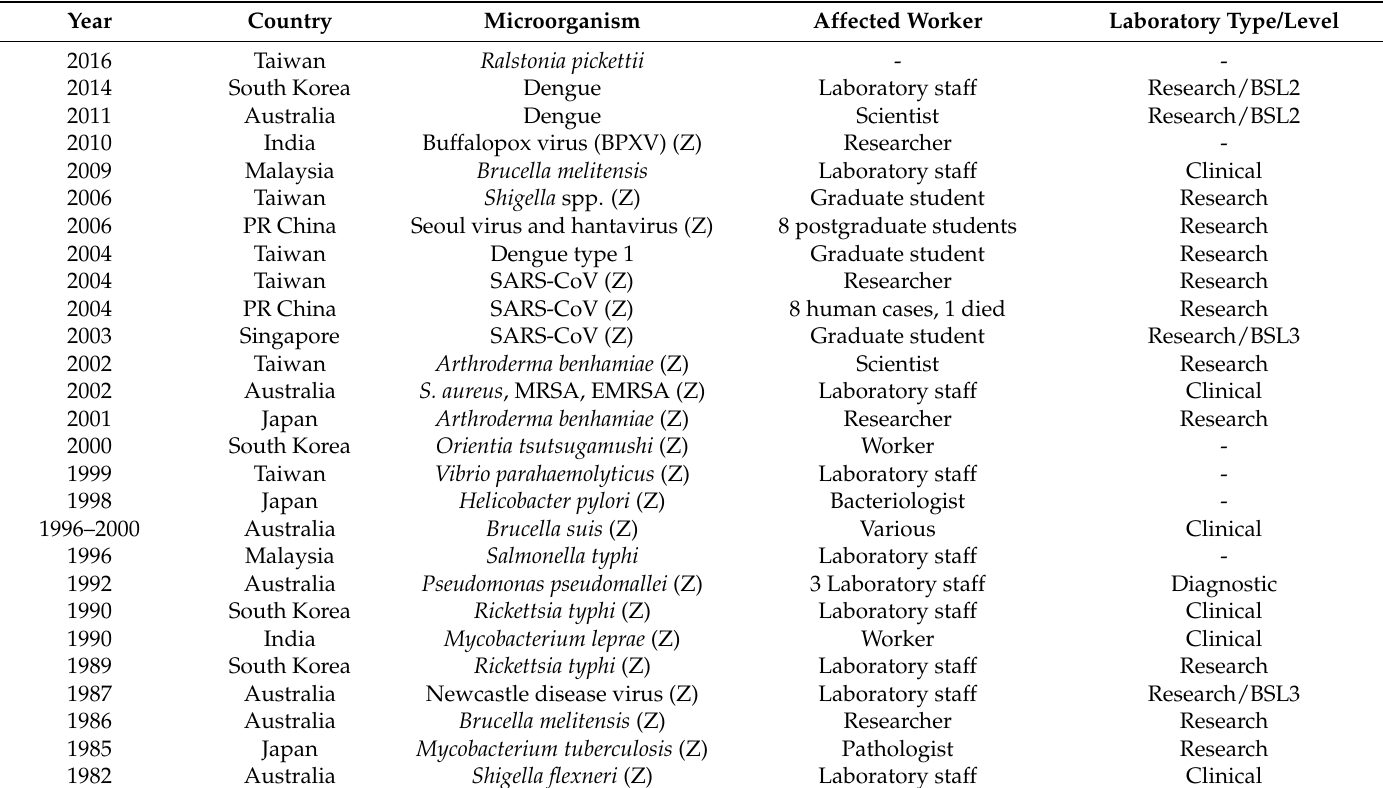
Table 1. Summary of the LAI reports in the Asia-Pacific